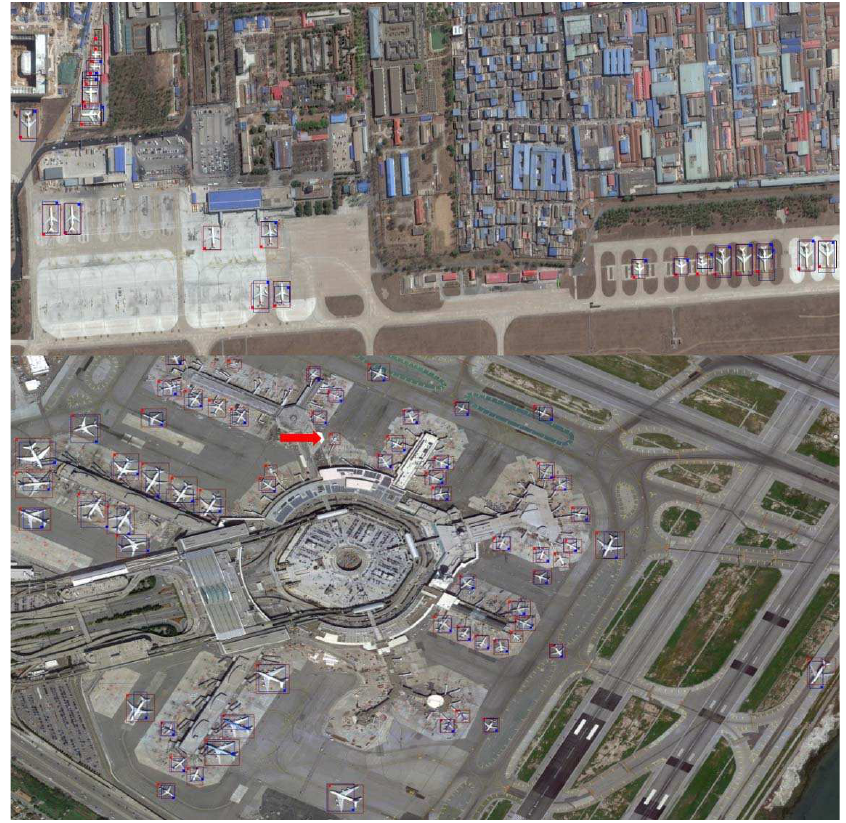
Figure 24. Examples of detection results on the LARGE-FIELD-RSIs